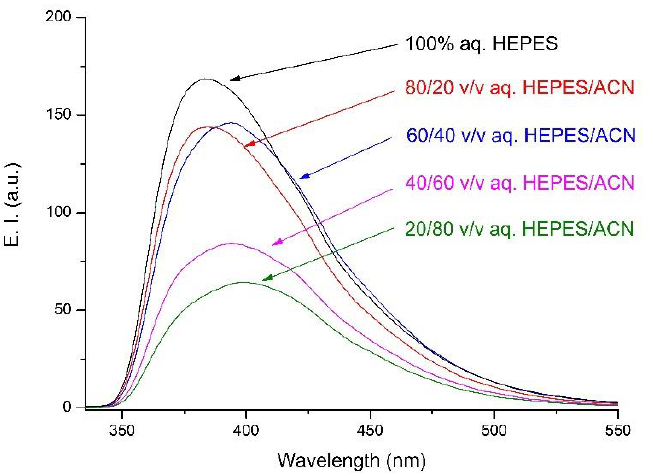
Figure 2. Fluorescence emission of L in different aqueous HEPES/ACN mixtures. [ L ] = 3.2 × 10 − 6 mol dm − 3 ; [HEPES] = 1.0 × 10 − 3 mol dm − 3 ; pH 7.4; λ ex = 305 nm.